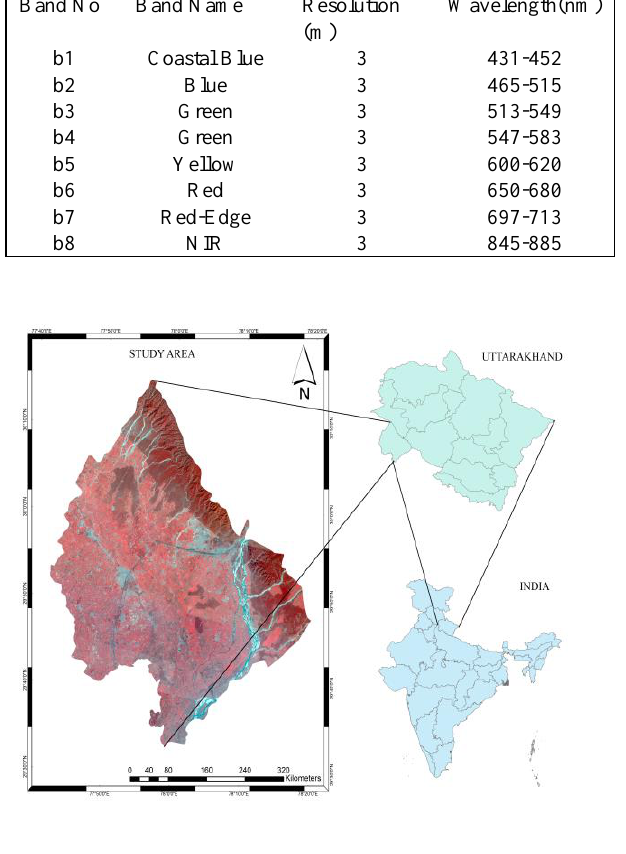
Figure 1. False colour composite (FCC) of the study area using PlanetScope Image